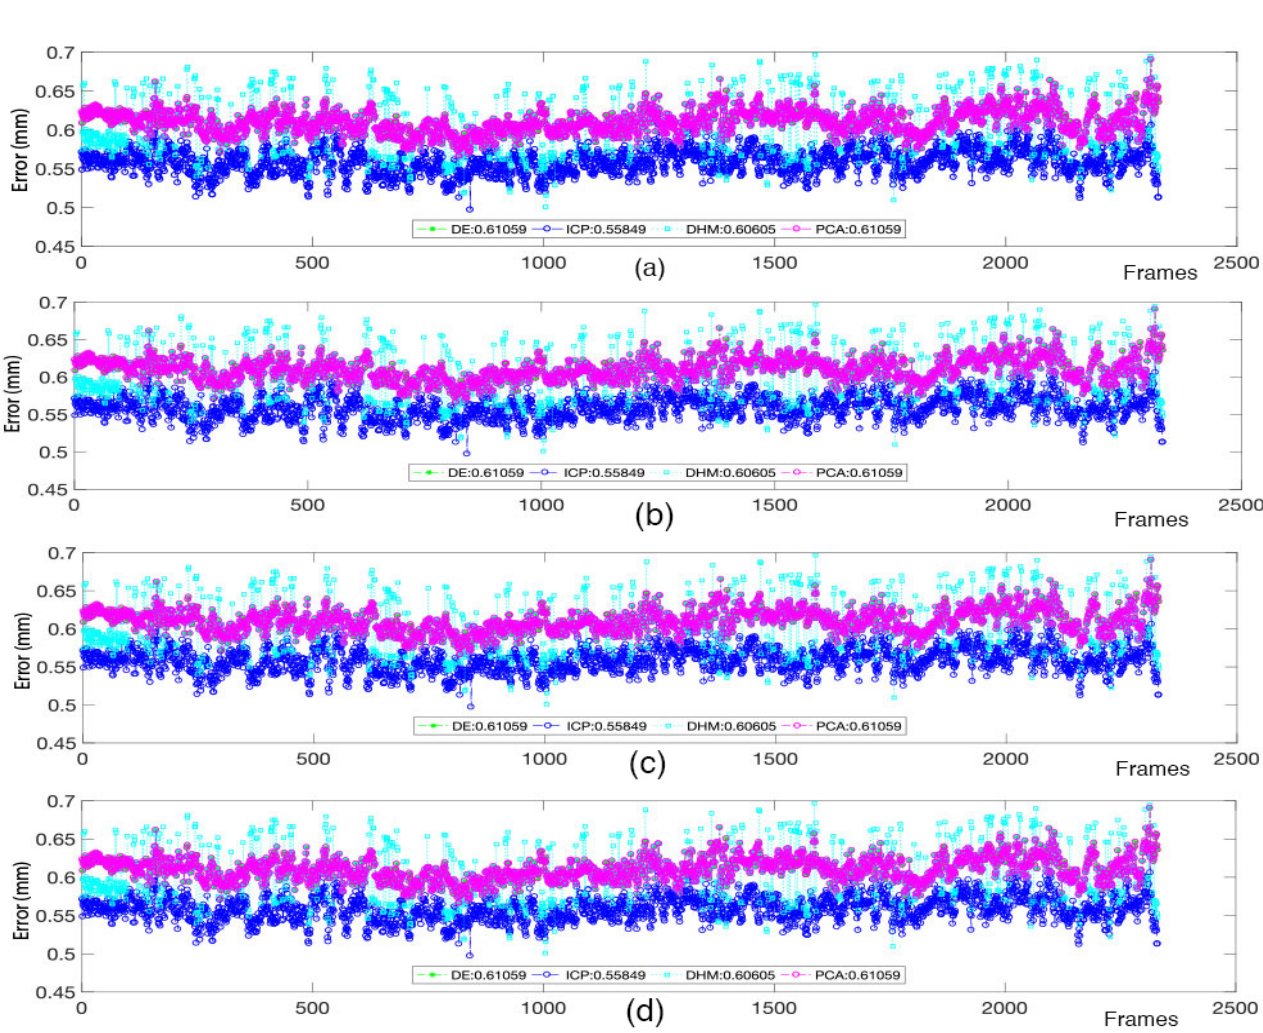
Fig. 10. Graphs showing the calculation of the error among the tested algorithms. (a) 25 percent (21 blendshapes); (b) 50 percent (41 blendshapes); (c) 75 percent (62 blendshapes) and (d) 100 percent (81 blendshapes).